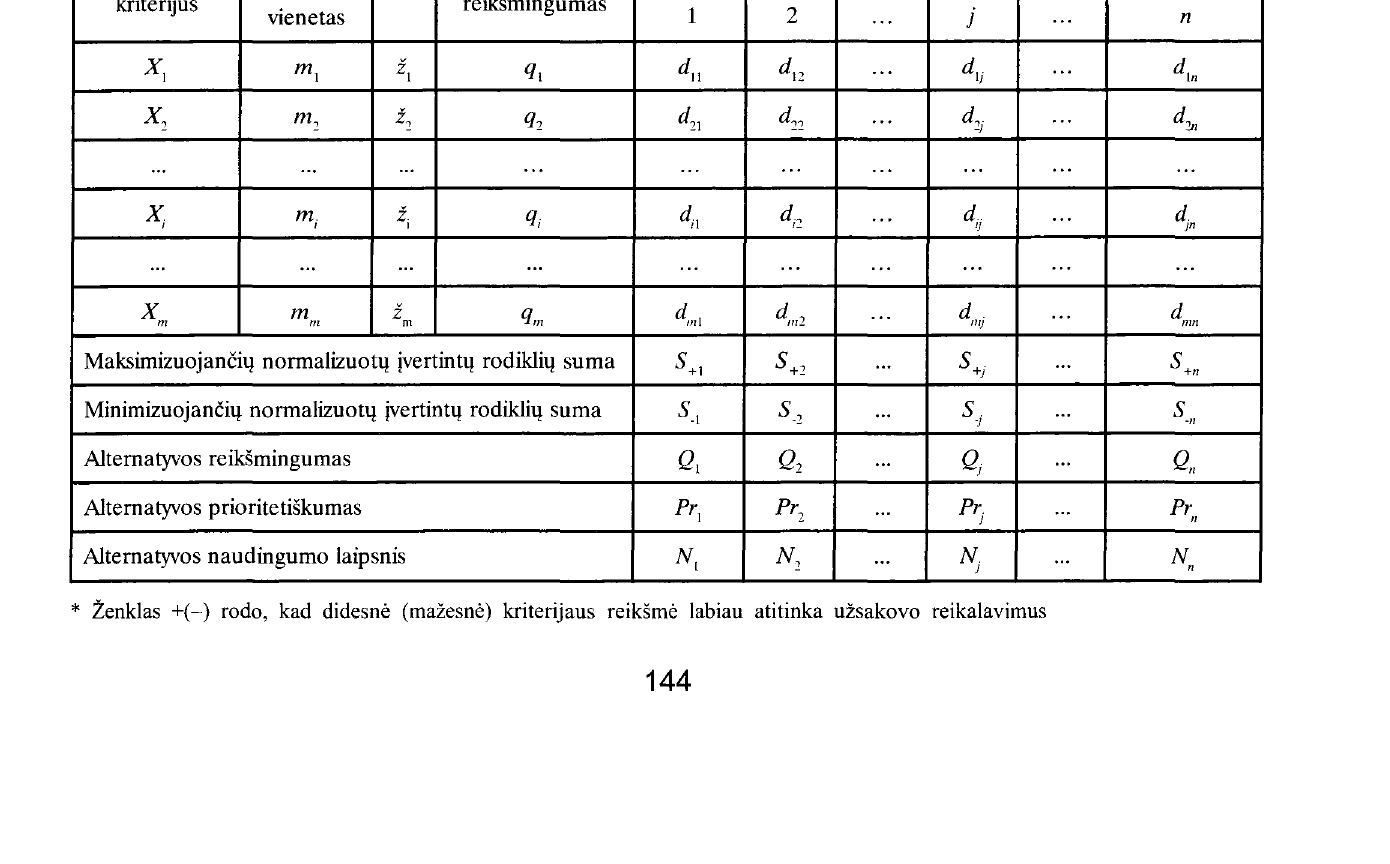
Table 3. Evaluated normalised decision-making matrix D and multiple criteria analysis results